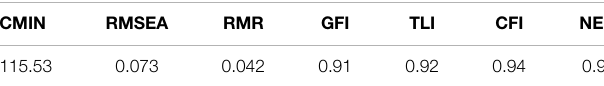
TABLE 2 | Southeast Asian countries: Goodness of fi t measure.